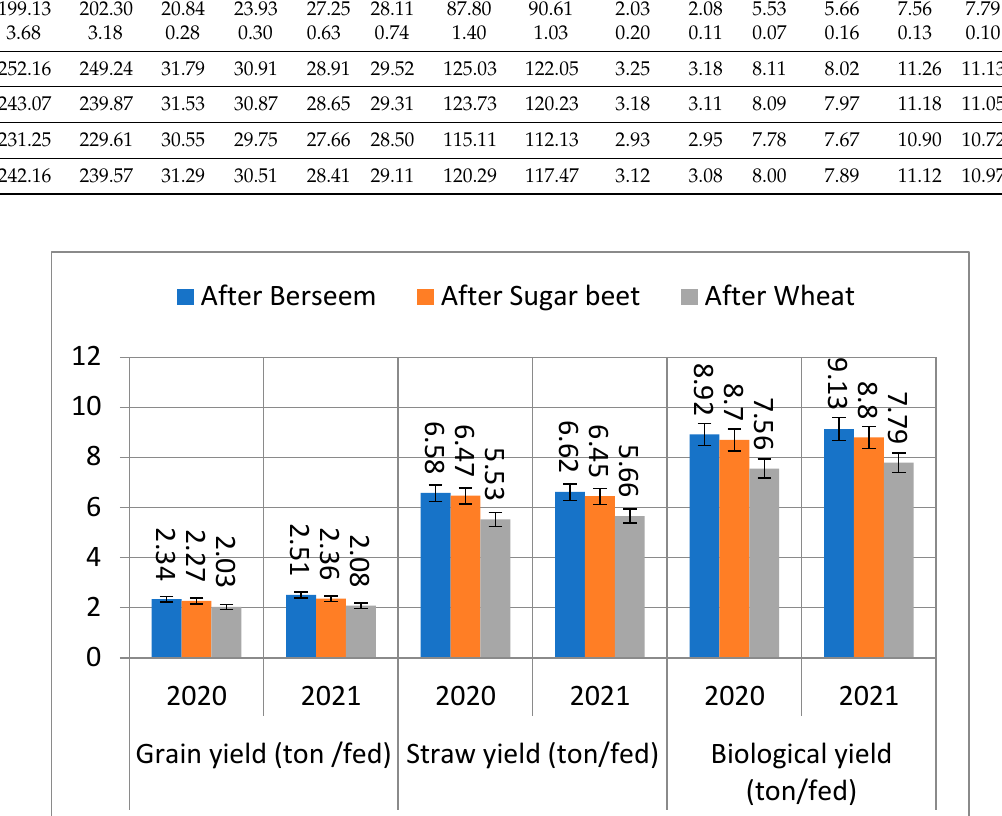
Figure 1. The effect of preceding crops on grain yield (ton/fed), straw yield (ton/fed) and biological yield (ton/fed) of maize during 2020 and 2021 seasons.